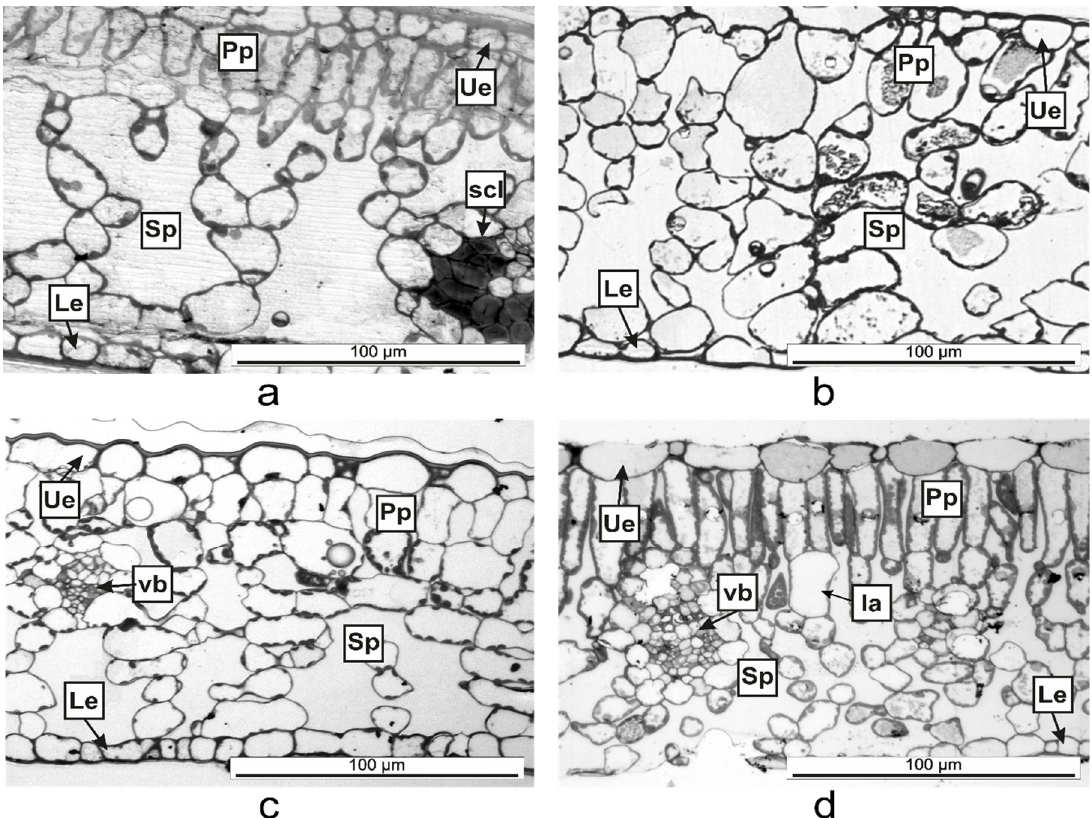
Figure 5. Semithin cross-sections of Vinca leaves showing the organization of the mesophyll between the upper epidermis (Ue) and lower epidermis (Le) as determined through light microscopy. ( a ) V. minor , ( b ) V. major , ( c ) V. major var. variegata , ( d ) V. herbacea ; Ia—idioblast, Pp = palisade parenchyma, scl—sclerenchyma, Sp = spongy parenchyma, vb = vascular bundle.